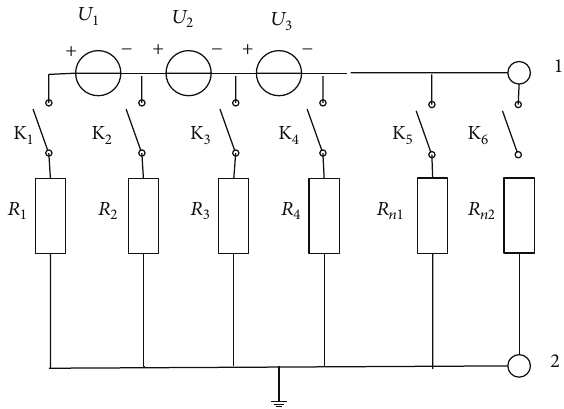
Figure 19: Simplified internal insulation resistance test model.